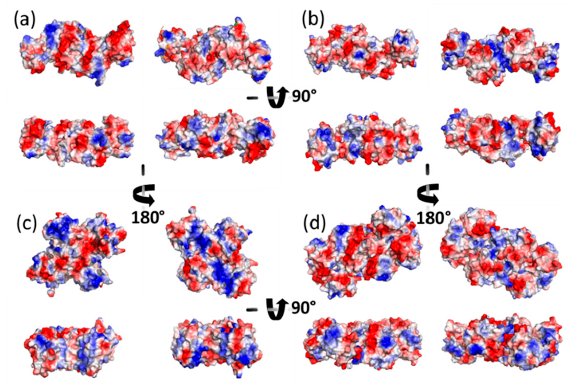
Figure A3. Surface electrostatic potential of homodimers for ( a ) GvFFTR, ( b ) CaFFTR2, ( c ) GvDDOR, and ( d ) the transient complex of GvFFTR with GvFdx as calculated by the PyMol Software from their PDB files (Table A1). Electrostatic potential values are shown on a scale from red through grey to blue, corresponding to − 8.5, 0 and +8.5 kT/e, respectively. For each structure, the top panels represent the two 180° views of the larger lateral surfaces, while the bottom figures represent the two 180° views of their corresponding heights (bottom figures are 90° rotated with respect to the corresponding top figures). Images were produced after alignment of all structures.